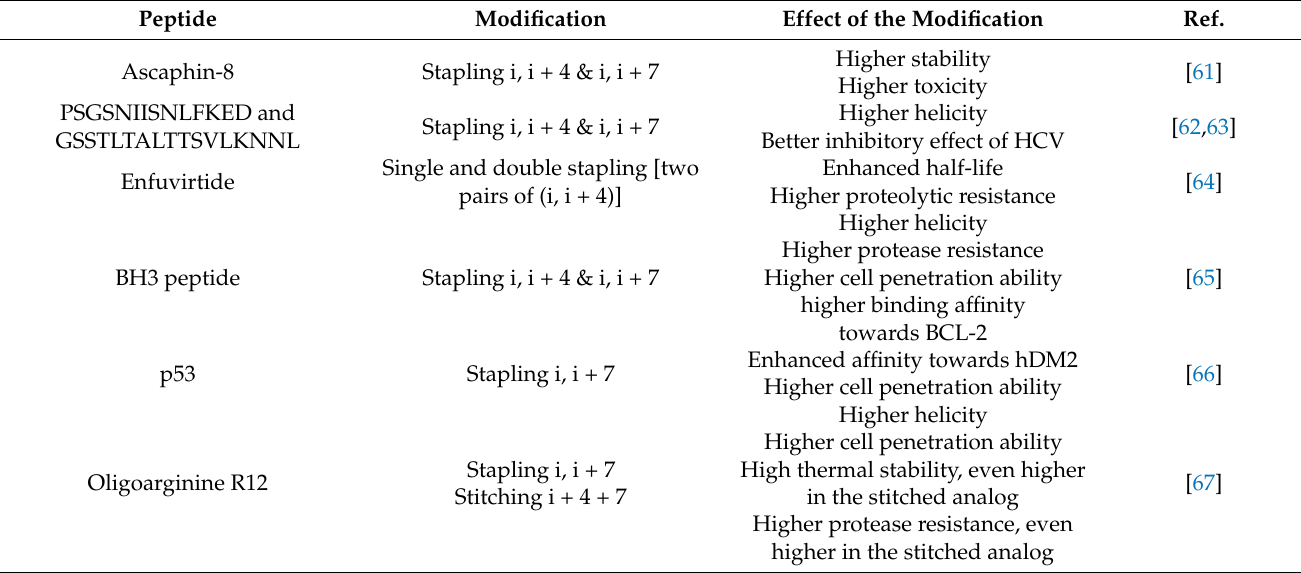
Table 1. Summary of the peptides and the modifications to overcome delivery